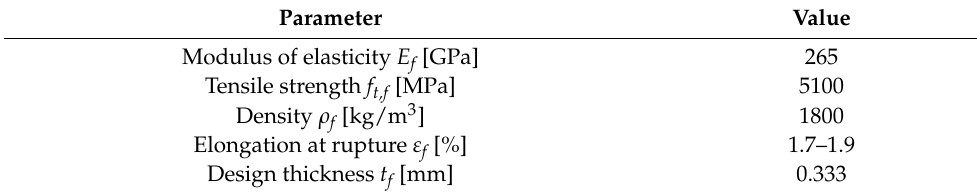
Table 2. Material parameters of CFRP sheet [33].